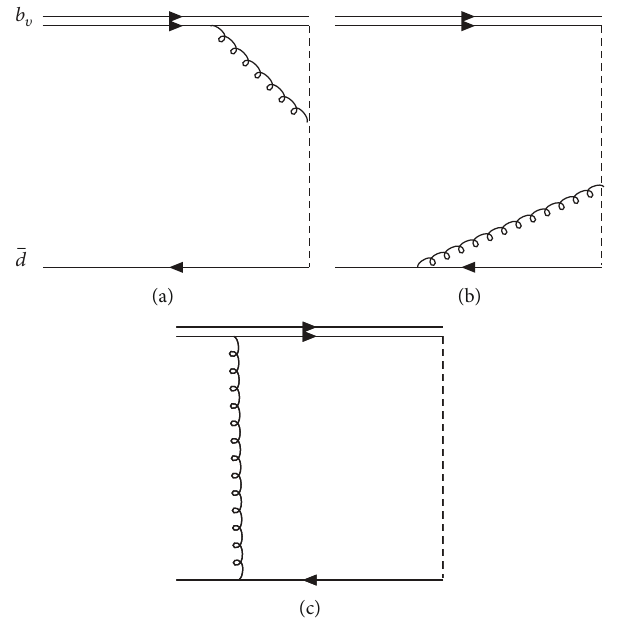
Figure 2: One-loop diagrams for the B -meson LCDA. The fi gure is reproduced from